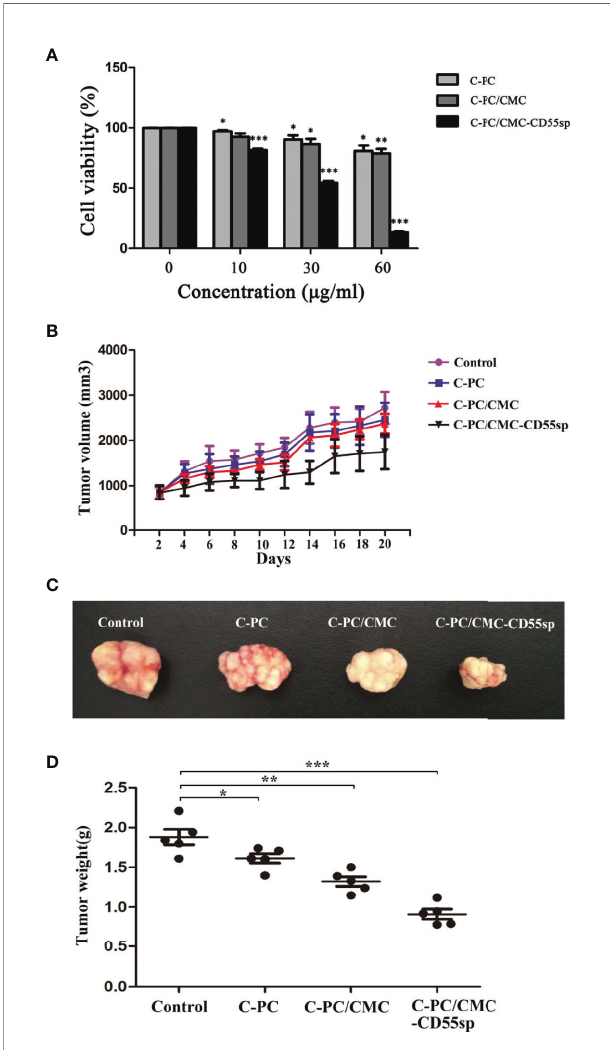
FIGURE 4 | Inhibitory effects of drugs on cell proliferation in vitro and in vivo. (A) Cell Counting Kit-8 (CCK-8) assay. The x-axis represents drug concentration (0, 10, 30, and 60 m g/ml), and the y-axis represents cell activity, as determined using the CCK-8 assay. Results are expressed as the mean ± SEM (n = 3). *P < 0.05, **P < 0.01, ***P < 0.001. (B) Tumor volume. The horizontal axis represents days and the vertical axis represents tumor volume (mm 3 ). (C) Tumor size. (D) Tumor weights. The vertical axis represents tumor weights (g). Results are expressed as the mean ± SEM (n = 5). *P < 0.05, **P < 0.01, ***P <